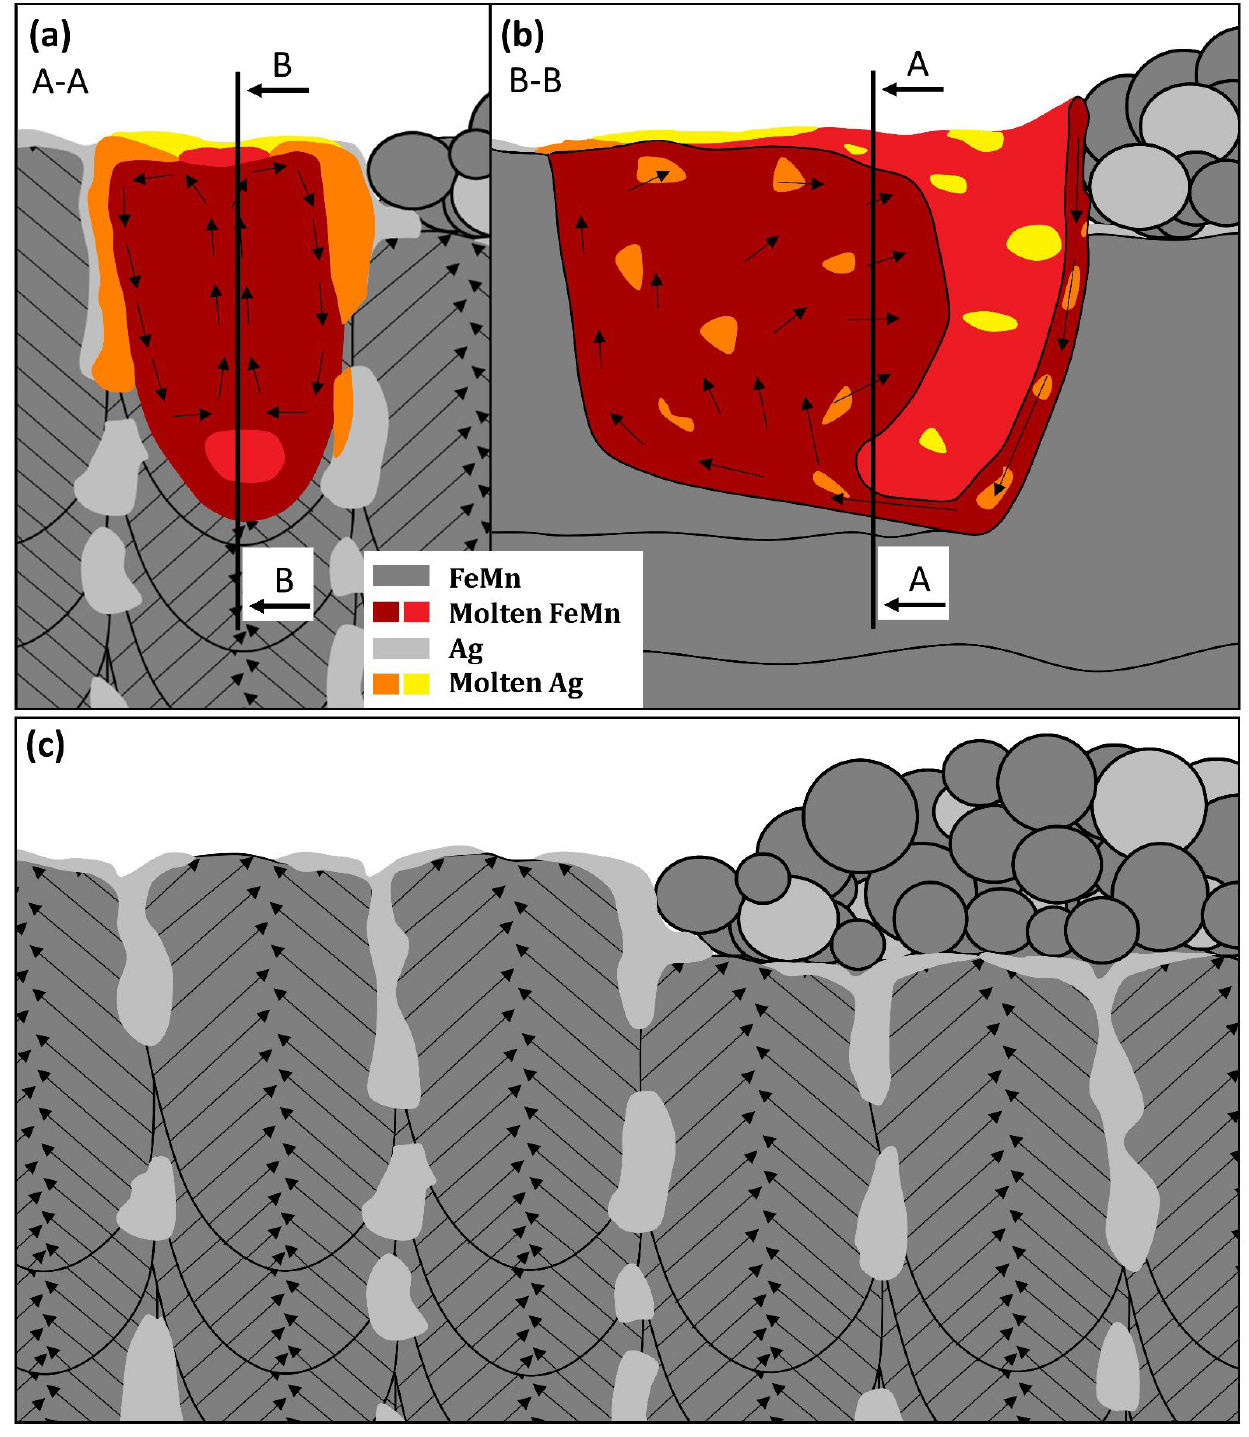
Figure 8. Formation of AgCaLa phases throughout the LBM process, schematic model; melt pool shape and melt flow adapted from [60,64,68,71,93,107]: ( a ) outward directed vortex of FeMn transporting AgCaLa to the flanks of the melt pool; ( b ) emerging of AgCaLa due to keyhole and accumulation on the top in the backward part of the melt pool due to surface tension; ( c ) distribution of AgCaLa in the top of LBM-manufactured material, with remaining AgCaLa phases at the lower end of the melt pools. As the AgCaLa is transported to the top of the melt pool, the AgCaLa in the upper part of the melt pool is remelted and transported upwards again with the generation of